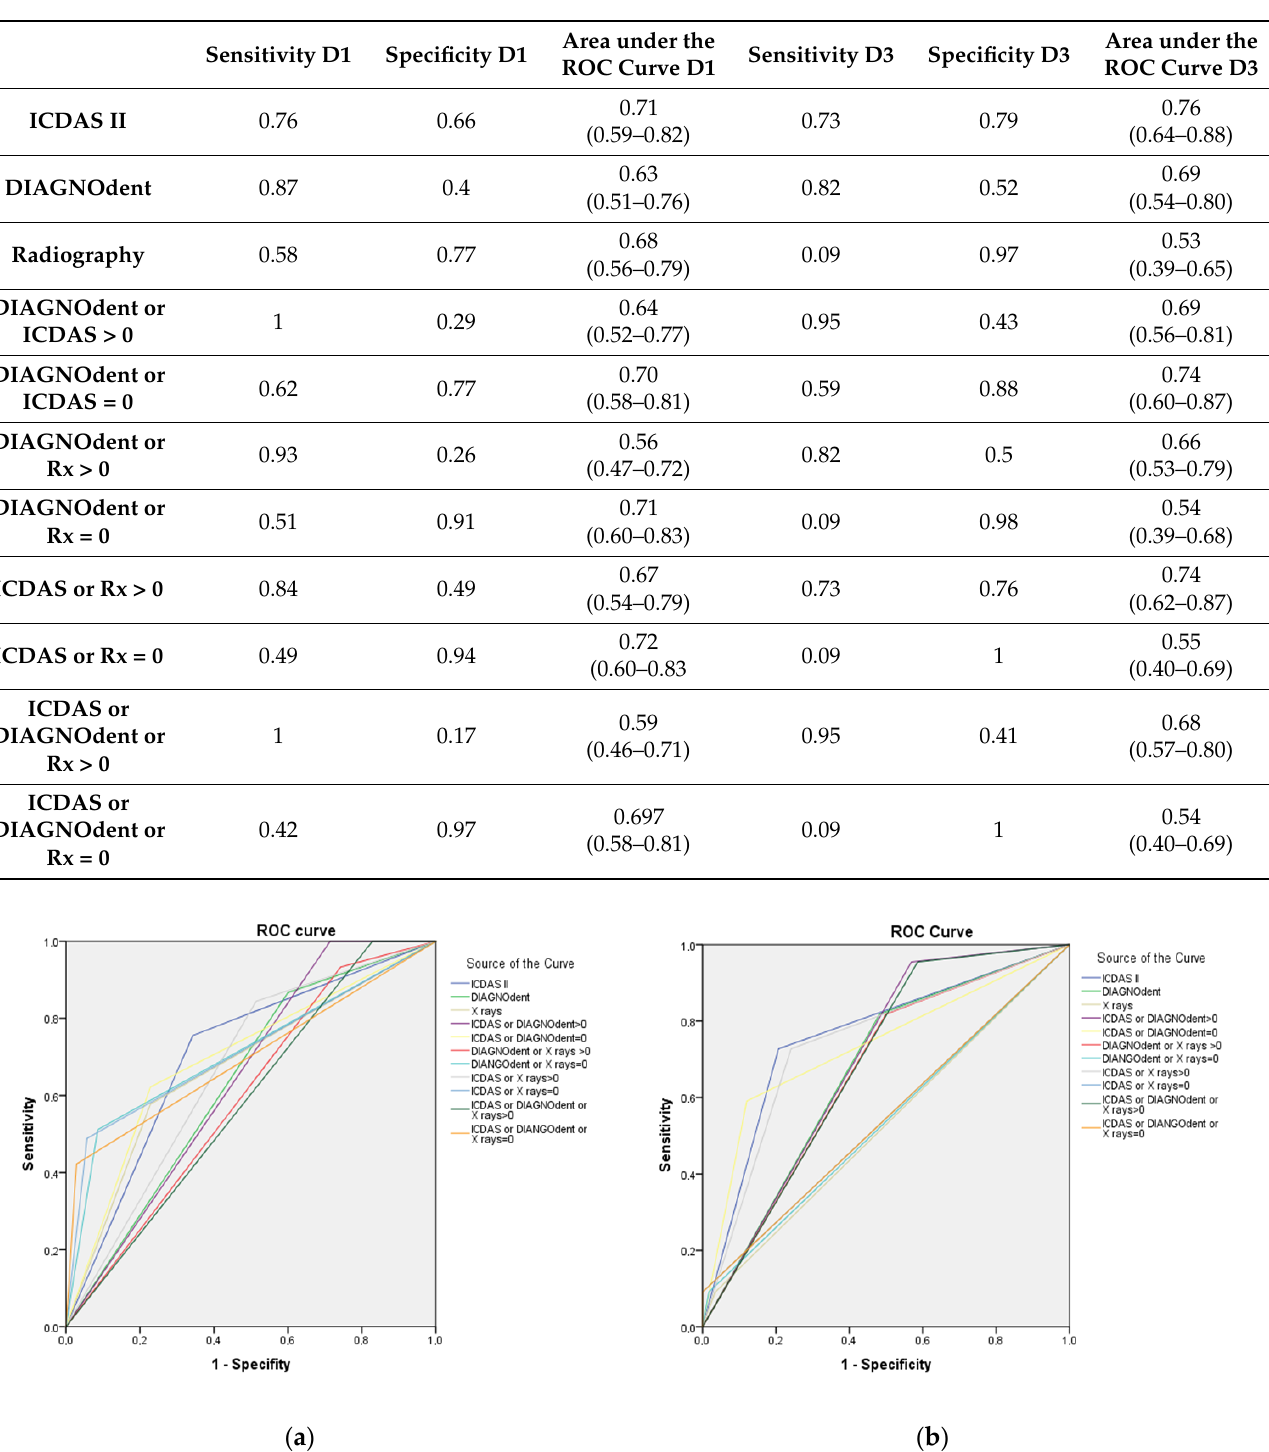
Table 2. Sensitivity, specificity and area under the ROC curve for ICDAS, DIAGNOdent, radiography and the combination of the three methods for the detection of caries lesions limited to enamel (D1) or dentin (D3).